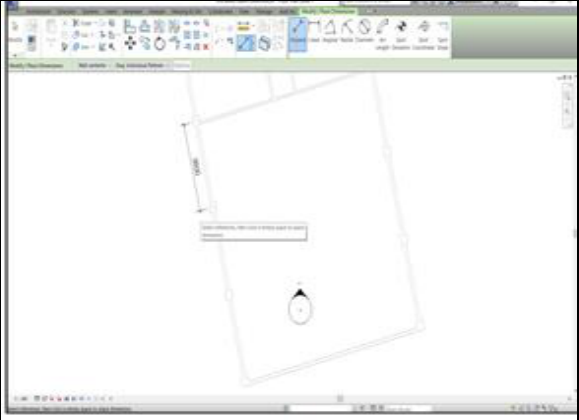
Figure 15. Dimensioning for MLS data in Revit